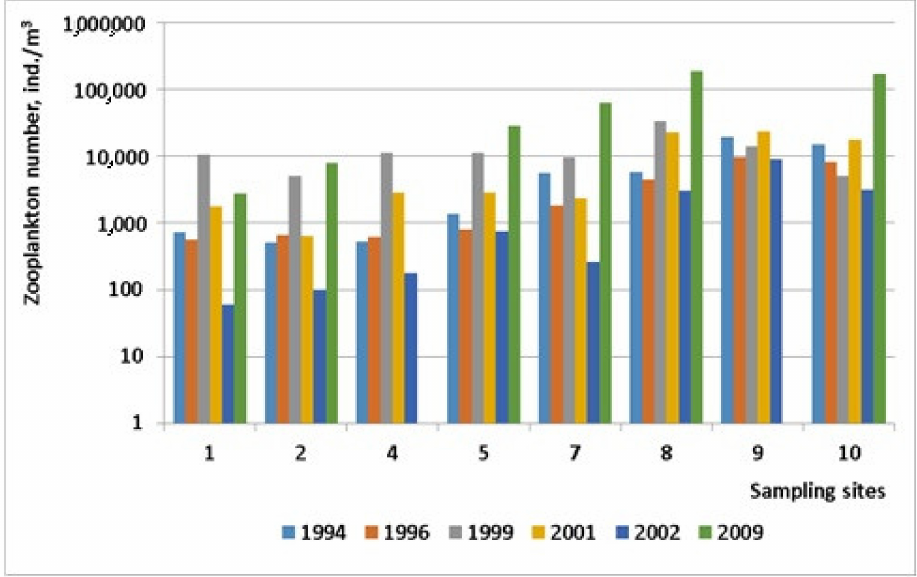
Figure 6. Dynamics of zooplankton densities in different sites of Ob River (sites numbers correspond to those specified in Table